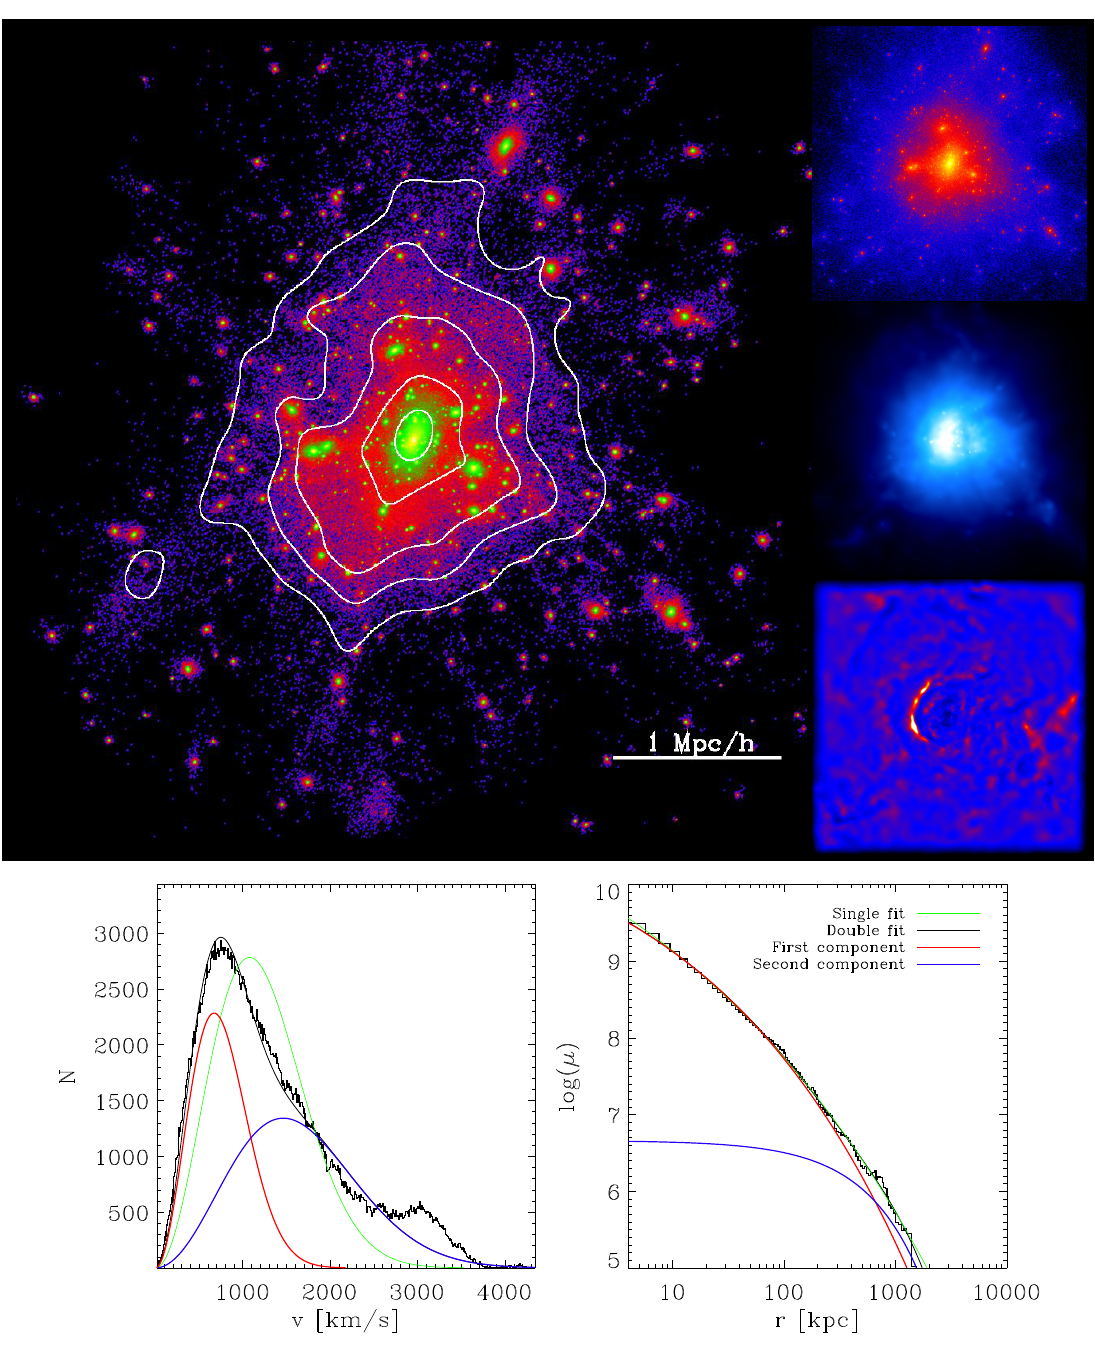
Figure 4. Same as Figure 1 but for a special case where a third component would be needed to describe the velocity distribution, while the radial surface density profile does not show signs of a third component. Since we do not explicitly study these special cases in this work, this cluster is classified as belonging belong to the d/d class, as both the velocity and the radial density clearly are multi-component